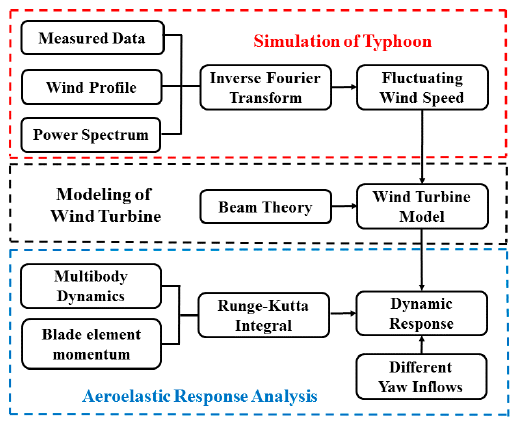
Figure 2. Block diagram structure of the analysis of wind turbine in typhoons.